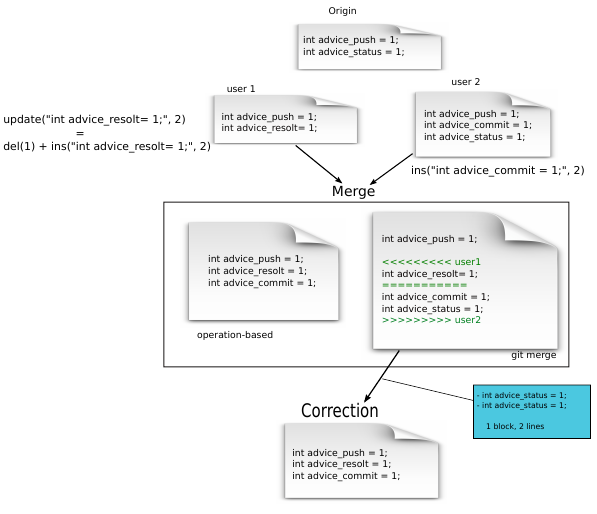
Figure 11. Addition at the same